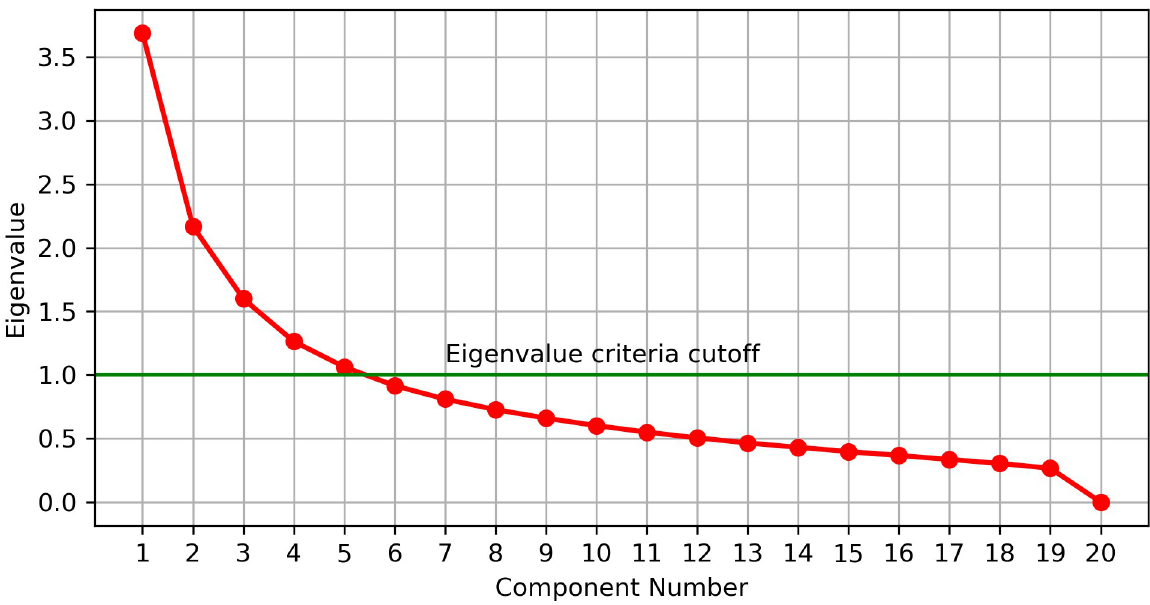
Fig 3. Scree plot for selecting the appropriate number of principal components for